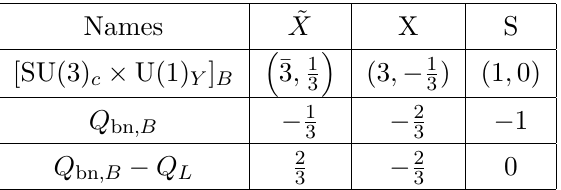
Table 2 . Charges of new scalar fields (in sector B) for the model of section